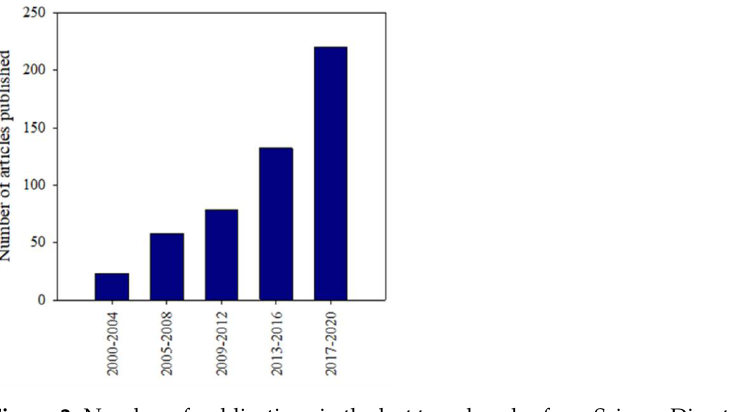
Figure 2. Number of publications in the last two decades from Science Direct website when keywords were: quartz crystal microbalance, sensors and VOCs.